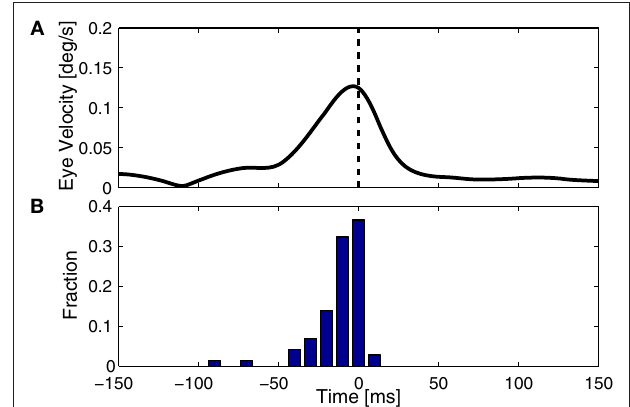
FIGURE 5 | Timing of cerebellar activity. (A) Shows a simple spike triggered average of eye velocity in response to white noise optokinetic stimulation. The white noise stimulus was provided by a panaromic projector system and consisted of a hexagonal matrix of green patches that were rotated coherently around the animal according to a three dimensional gaussian white noise process fi ltered through a 20-Hz low-pass fi lter. Note that the curve of this neuron peaks slightly before 0 ms, i.e. the P-cell is active slightly after the actual movement. (B) Summarizes the timing of the peak in 71 Purkinje cells, showing activity that more or less coincides with the movement (Winkelman and Frens,